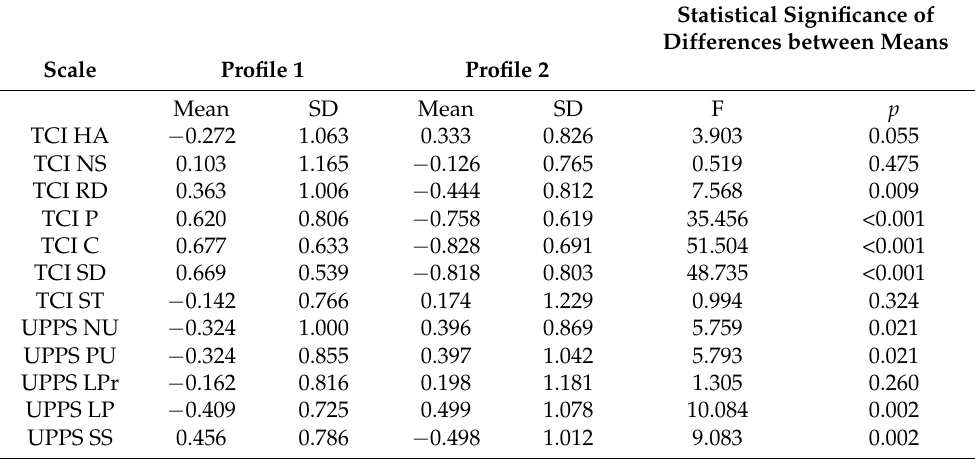
Table 3. Statistical measures of temperamental, character and impulsiveness